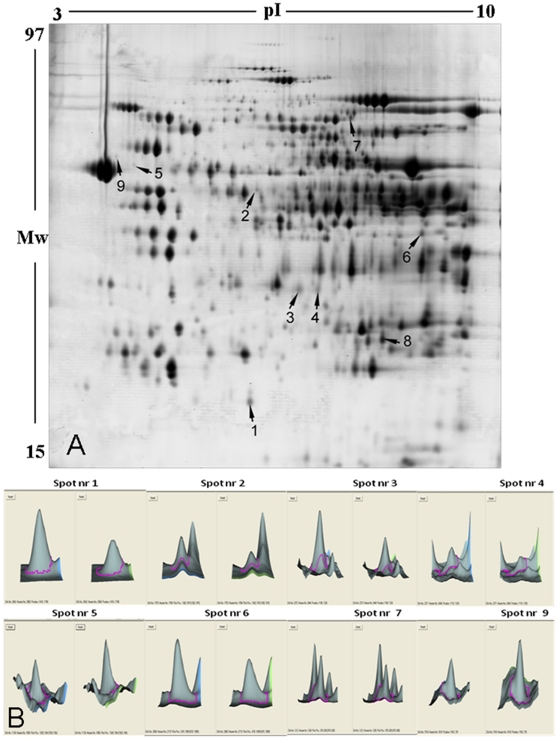
Two-dimensional separation of proteins from mouse heart mitochondria using DIGE approach.
A. Indicated spots show significant increase or decrease in expression (t-test, p≤0.05) after image analysis in DeCyder software (GE Healthcare). Five independent biological and two technical replicates of each were used for the statistical analysis. B. The three-dimensional structure of spots (left sham, right 2 Gy) with numbers 1, 2, 3, 4, 5, 6, 7, 9 are shown.